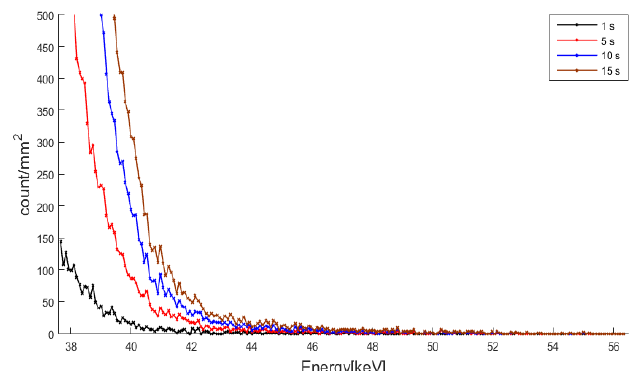
Figure 10. The energy spectra at 40 kVp and 200 μ A. The photon counts on 1 mm 2 are appearing above 40 keV because of the noise and pileup